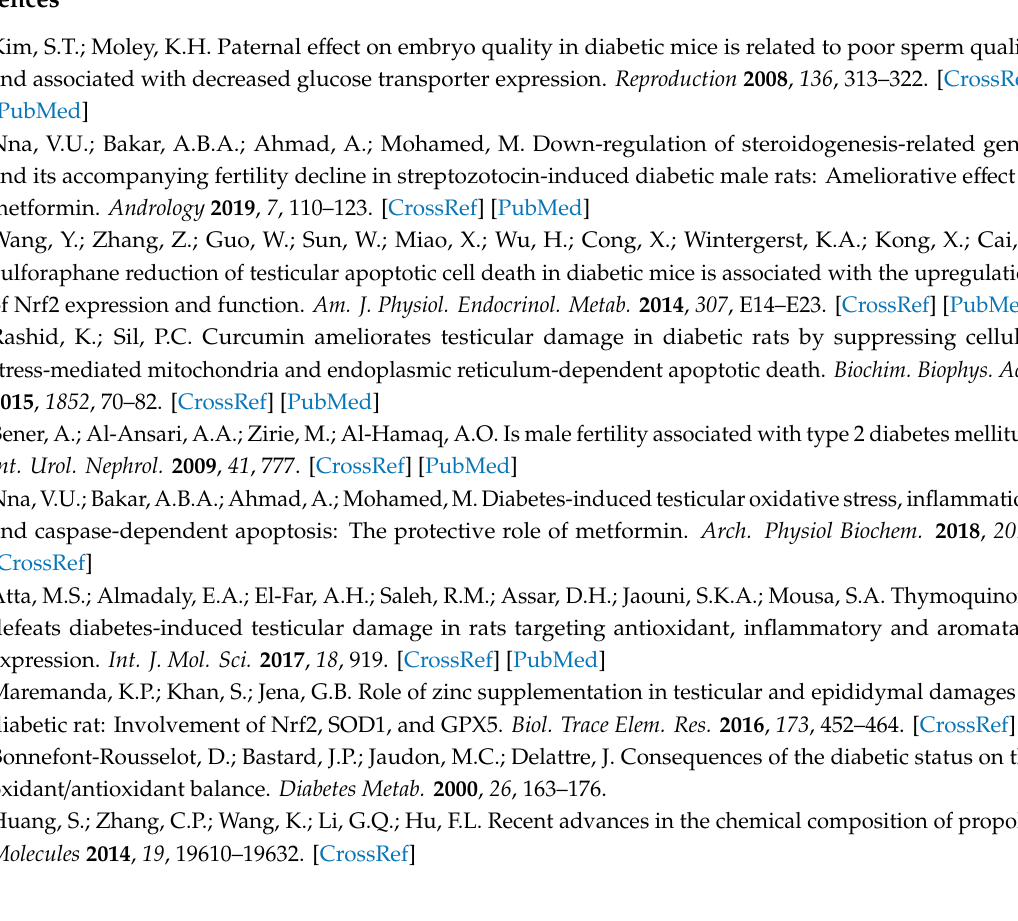
Table S1: Oligonucleotides used for PCR amplification of antioxidant, inflammation and apoptosis-related